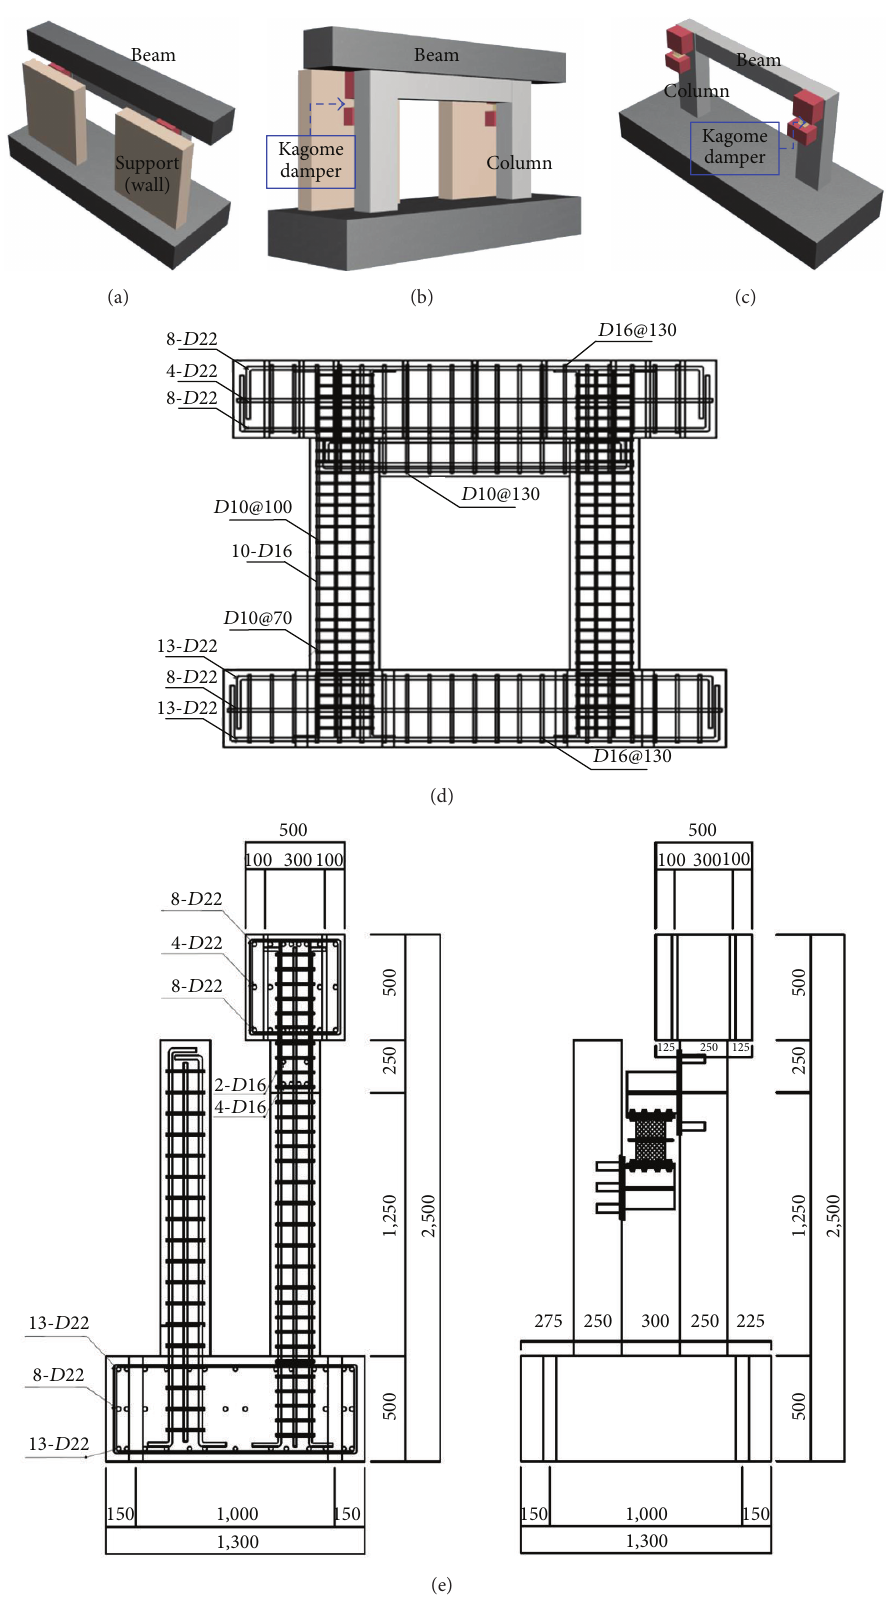
Figure 5: Configuration and details of test specimens: (a) rear view, (b) front view, and (c) inside view of specimen strengthened with a Kagome damper. (d) Details of control specimen and (e) specimen strengthened with a Kagome